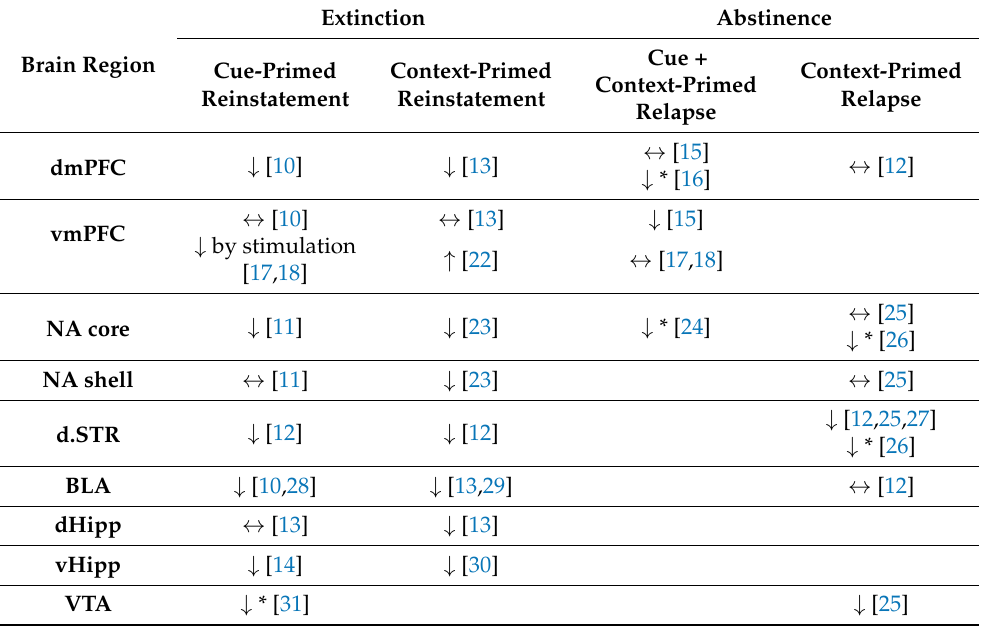
Table 1. Neurocircuitry of cocaine relapse after abstinence or extinction. Arrows indicate the effect of inactivation of this brain region (using pharmacological, chemogenetic, or optogenetic strategies) on relapse. Effects of stimulation are also noted for the vmPFC. * indicates that instead of inactivation strategies, glutamate receptor antagonism was used. Grey text is used to indicate studies in which discrete cues were not paired with intravenous cocaine